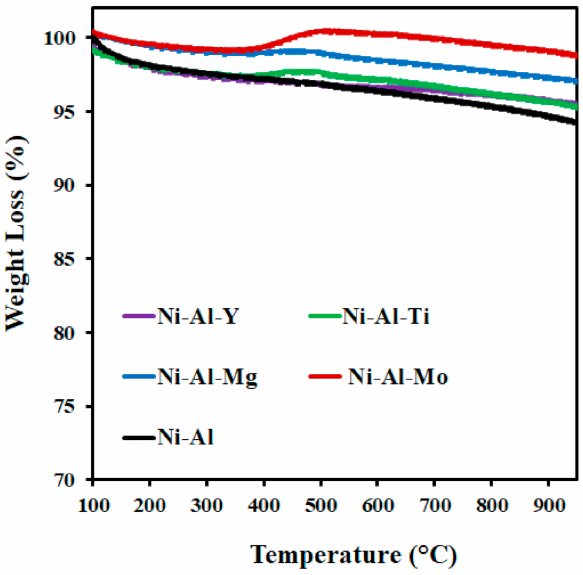
Figure 5. TGA of the spent catalysts tested at 550 ◦ C.